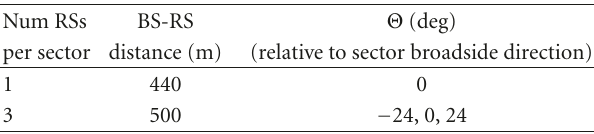
Figure 2: Coverage area for BS and RS in wide area test scenario. Table 1: RS deployment in the wide area test